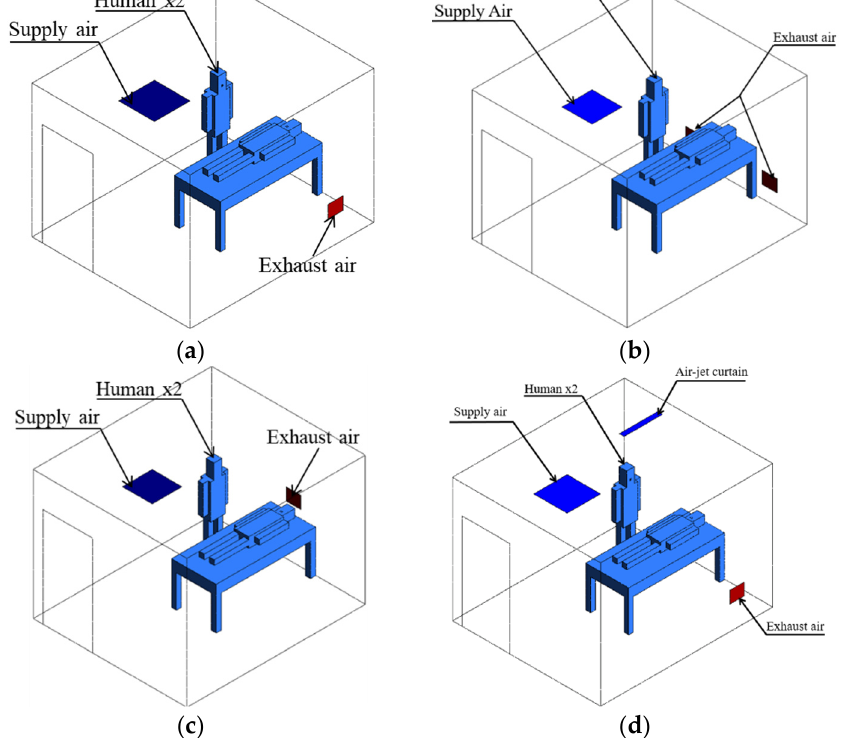
Figure 2. The geometry model of the isolation room based on ventilation strategies: ( a ) case 1 (existing model); ( b ) case 2 (two exhaust air grilles); ( c ) case 3 (exhaust air grille above head); ( d ) case 4 (case 1 with air-jet curtain).